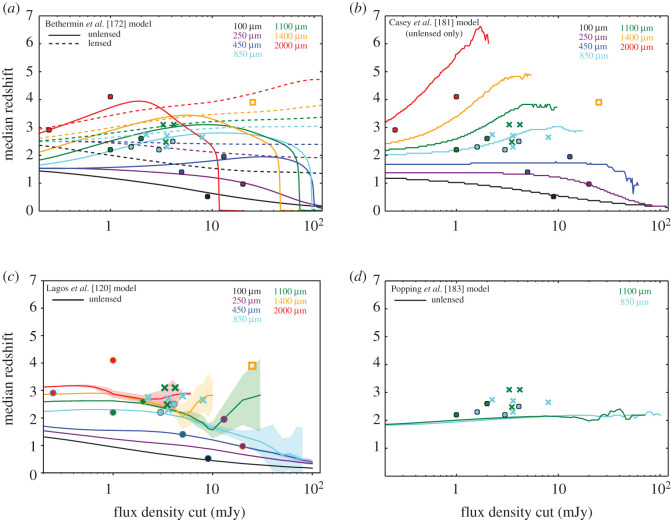
Median redshift of (sub-)millimetre selected galaxies as a function of flux density cut. The observational data are indicated by the filled circles (single dish) and crosses (interferometric follow-up) as listed in table 2. The open square indicates the interferometric follow-up of lensed SMGs from Strandet et al. [163]. We note that we chose not to include error bars for the observational points because the errors across the literature are not derived in the same consistent manner, and therefore are not comparable. The lines are the predictions from various semi-empirical (a,b) and semi-analytic (c,d) models. The observational constraints on such models are still sparse and limited by selection effects, but the current constraints on the median redshift from surveys with interferometric follow-up are broadly consistent with single-dish surveys within the uncertainties. (a) Model curves are from the empirical model of Béthermin et al. [172] and indicate unlensed (solid lines) and lensed (dashed lines) predictions. The predicted impact of strong lensing is evident in the figure and is due to the increased probability of lensing at high redshift. Figure adapted from Béthermin et al. [180]. (b) Model curves are from Casey et al. [181], using a simulation spanning 10 deg2 and assuming the Zavala et al. [182] description of the high-redshift infrared luminosity function. The model curves cut off when there are fewer than 50 sources in the simulated volume due to increasing noise in the curves. The difference between the Casey et al. [181] and Béthermin et al. [172] models demonstrates the uncertainty that still exists in the infrared luminosity function at high-redshift. (c) Model curves are from the semi-analytic shark model of Lagos et al. [120]. (d) Model curves are from the semi-analytic model of Popping et al. [183]. The semi-analytic models show very different results: both models show much weaker evolution of the median redshift with flux density cut. The model of Lagos et al. [120] does predict some evolution with selection wavelength, while that evolution is not seen for the Popping et al. [183] models for the two available wavelengths. The differences are possibly attributed to different modelling of dust emission in different codes.